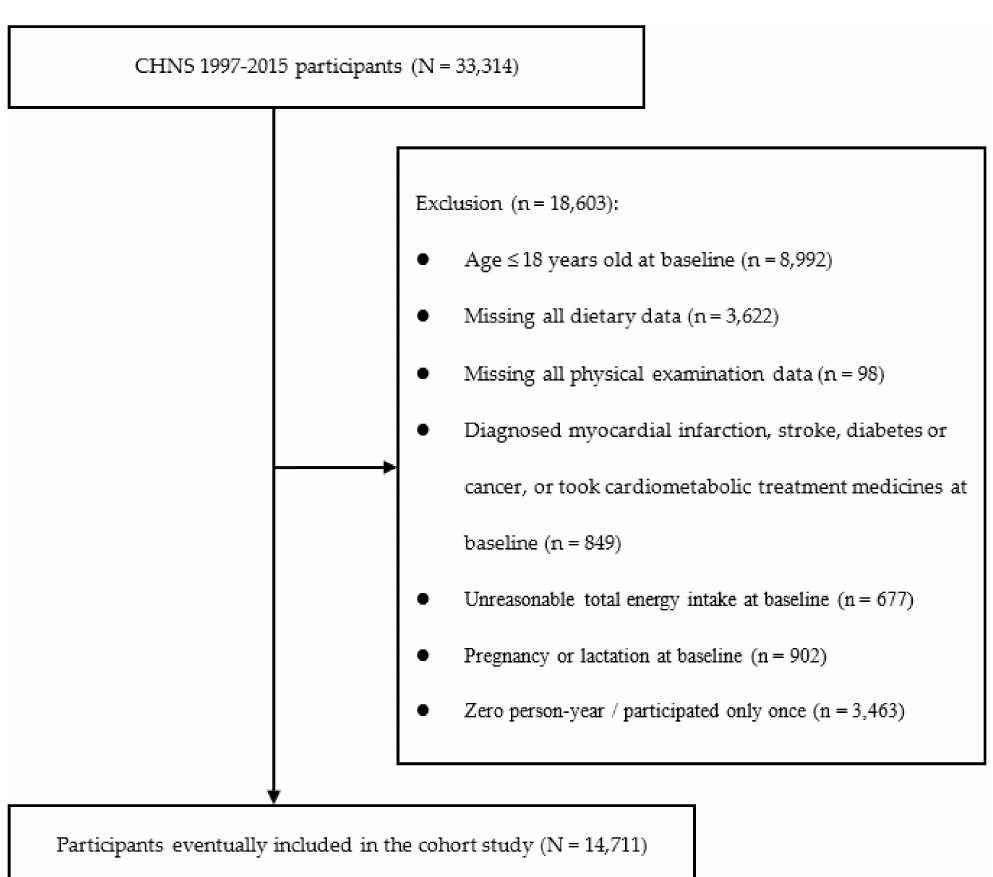
Figure 1. Flow chart of the prospective study with 14,711 Chinese adults from the China Health and Nutrition Survey (CHNS),